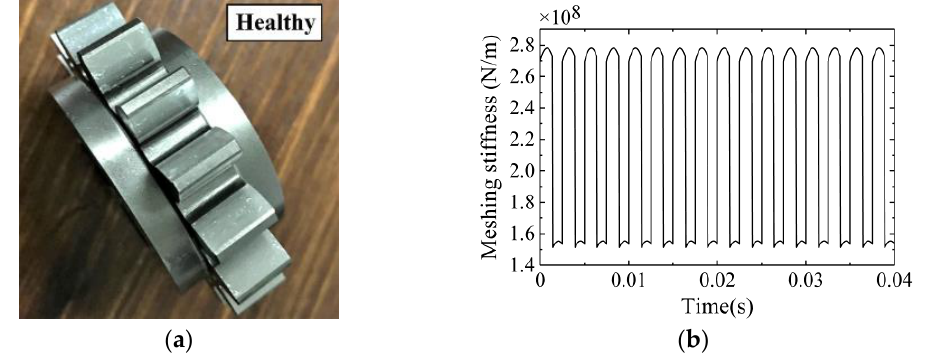
Figure 7. Status of tooth surface and mesh stiffness curves (healthy pinion): ( a ) status of tooth surface and ( b ) mesh stiffness curves.